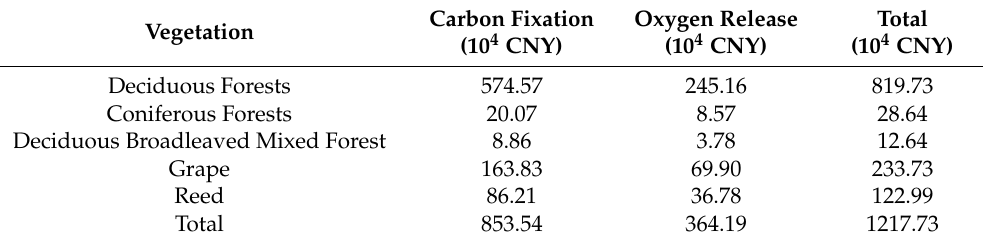
Table 7. The climate regulation service value in Lakeside Wetland